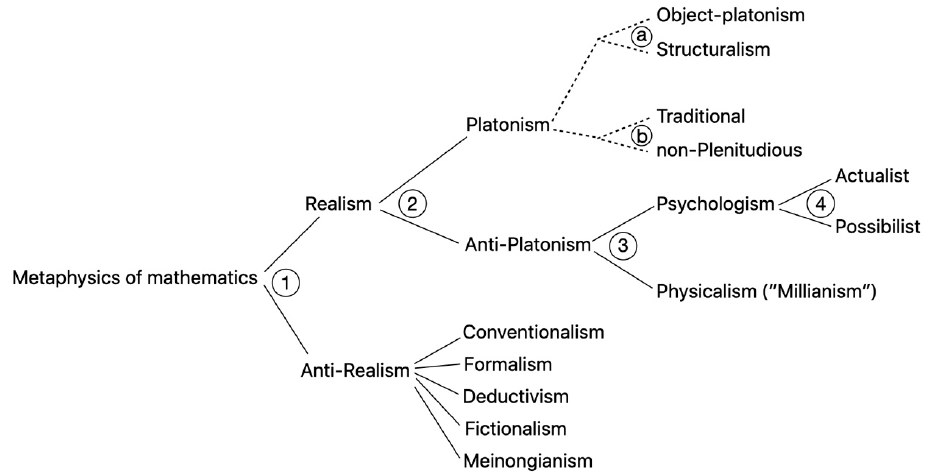
Figure 1. Key branches of mathematical ontology, with nodes (1–4) formed by answers to several key questions discussed in further text. (a) and (b) represent two alternative divisions of Platonism. Physicalism is subscripted as some of its ideas, including the essence of the physical nature of mathematical objects, are being defended in this analysis, while Platonism of sets and fictionalism are emphasized as the only two that, according to Balaguer, are capable of answering all objections.